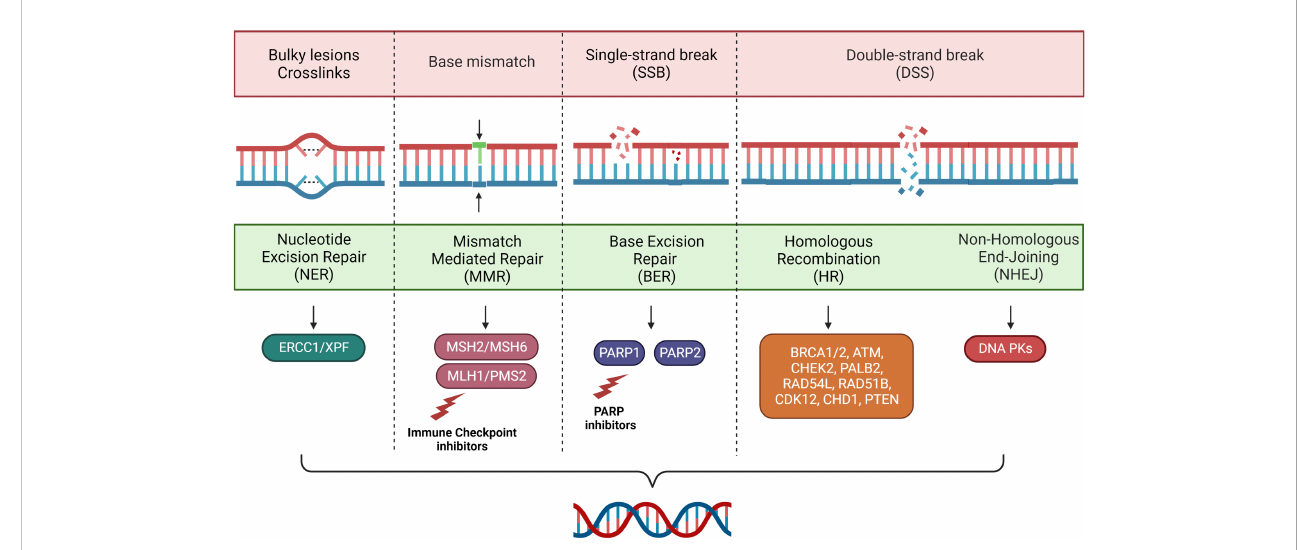
FIGURE 1 Main mechanisms of DNA